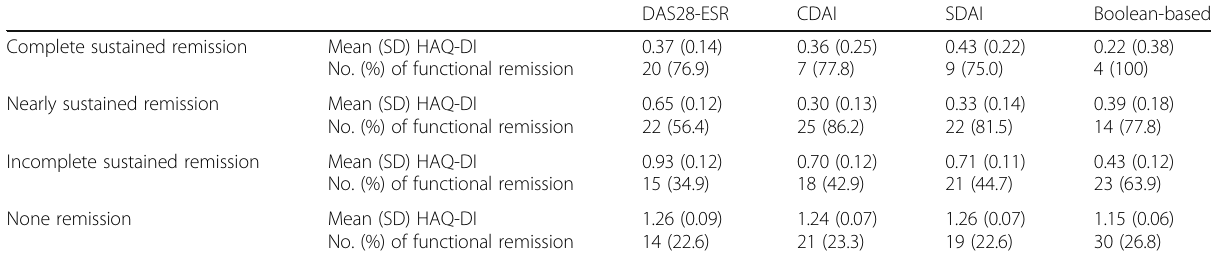
Table 3 Functional disability of patients who sustained clinical remission according to each criterion during follow-up period